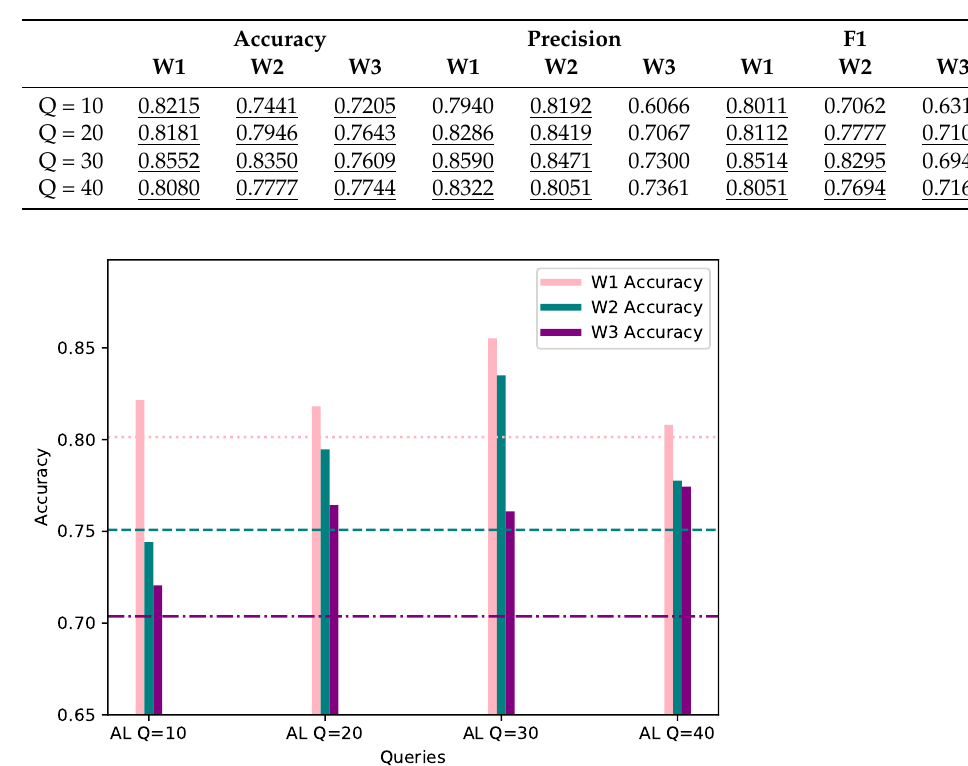
Table 3. Evaluation of W1, W2 and W3’s personalized models generated with 50% AL dataset bias after Q = 10,20,30,40 queries, using their corresponding evaluation datasets. Underlined results mean increased metrics in comparison with the corresponding FL evaluation.